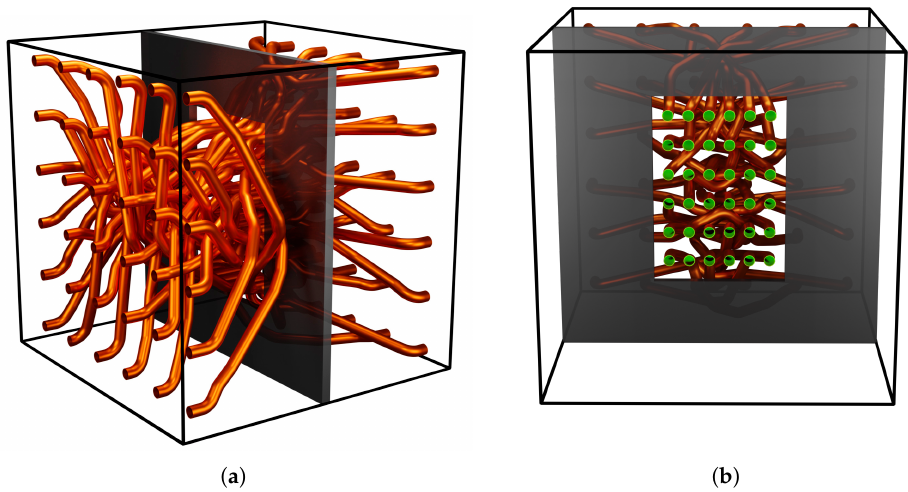
6 pipes, ( b ) half of 6